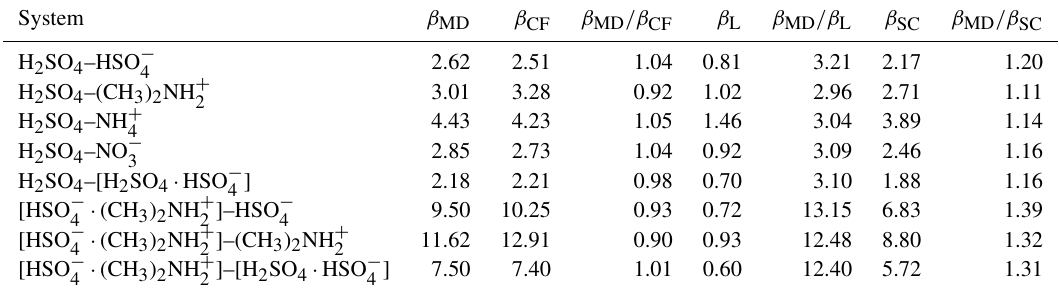
Table 2. Collision rate coefficients obtained from the molecular dynamics collision simulations β MD , central field model with interaction parameters fitted to the PMF curve β CF , Langevin–Gioumousis–Stevenson (Langevin, 1905; Gioumousis and Stevenson, 1958) model β L , and Su and Chesnavich (1982) parametrization β SC , for all studied systems in 10 − 15 m 3 s − 1